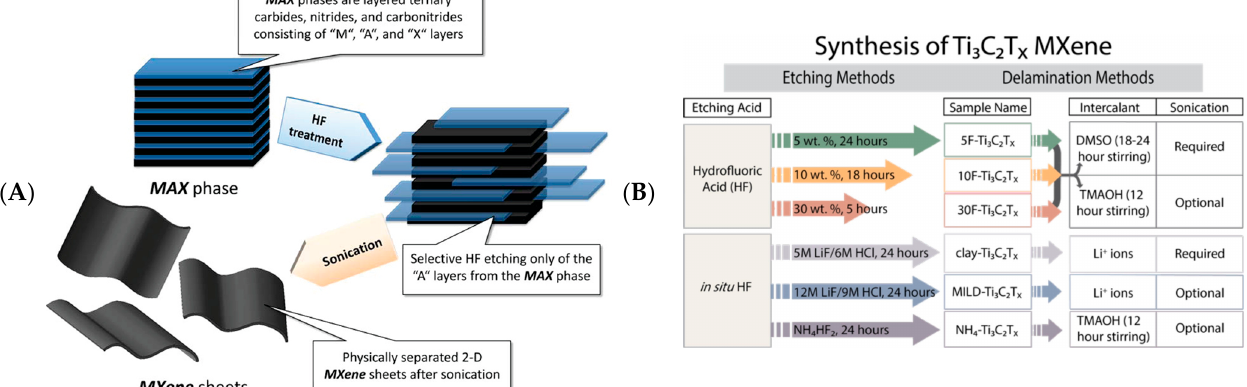
Figure 2. (A) Schematic diagram of the process of preparing MXenes by HF. Reprinted with permis- sion from Ref. [21]. Copyright 2012, American Chemical Society. (B) A guide to Ti 3 C 2 MXenes syn- thesis using HF. Reprinted with permission from Ref. [22]. Copyright 2017, American Chemical So- ciety.